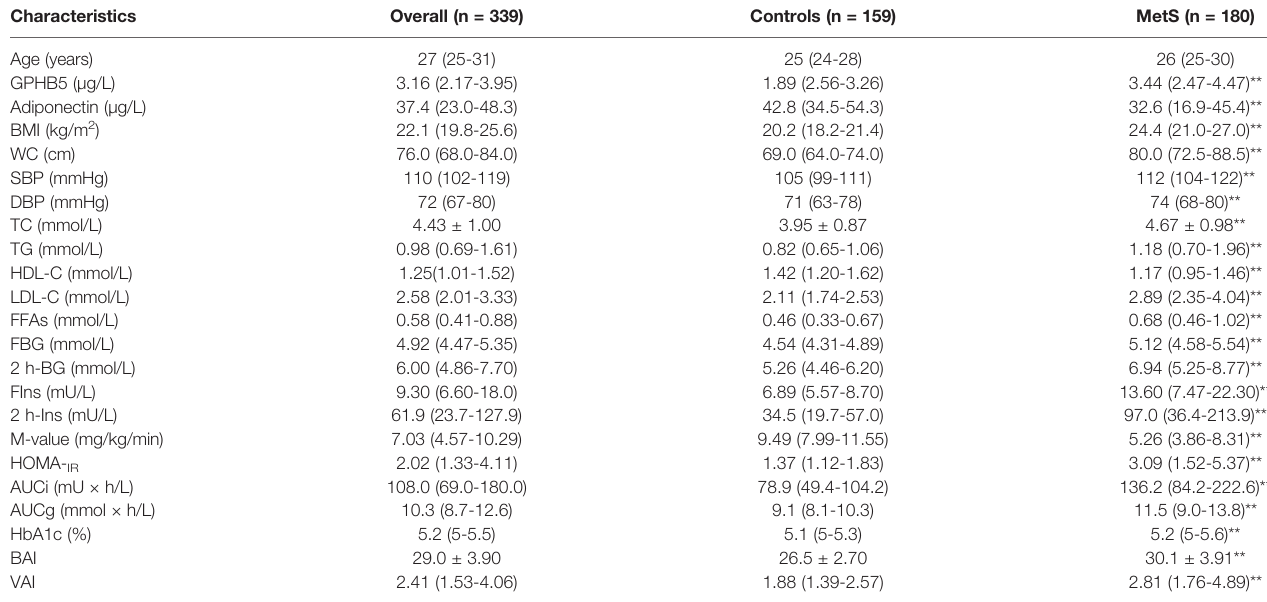
Valuesaregivenasmean±SDormedian(InterquartileRange).MetS,MetabolicSyndrome;BMI,bodymassindex;WC,waistcircumference;SBP,systolicbloodpressure;DBP,diastolic blood pressure; FBG, fasting blood glucose; 2 h-BG, 2h blood glucose after glucose overload; FIns, fasting plasma insulin; 2 h-Ins, 2h serum insulin after glucose overload; M-value, the rate of glucose infusion; TG, triglyceride; TC, total cholesterol; HDL-C, high-density lipoprotein cholesterol; FFA, free fatty acid; HOMA- IR , homeostasis model assessment of insulin resistance; AUCg, the area under the curve of glucose during oral glucose tolerance test; AUCi, the area under the curve of glucose during insulin tolerance test; VAI, visceral adiposity index; BAI, body adiposity index. **p < 0.01 vs.